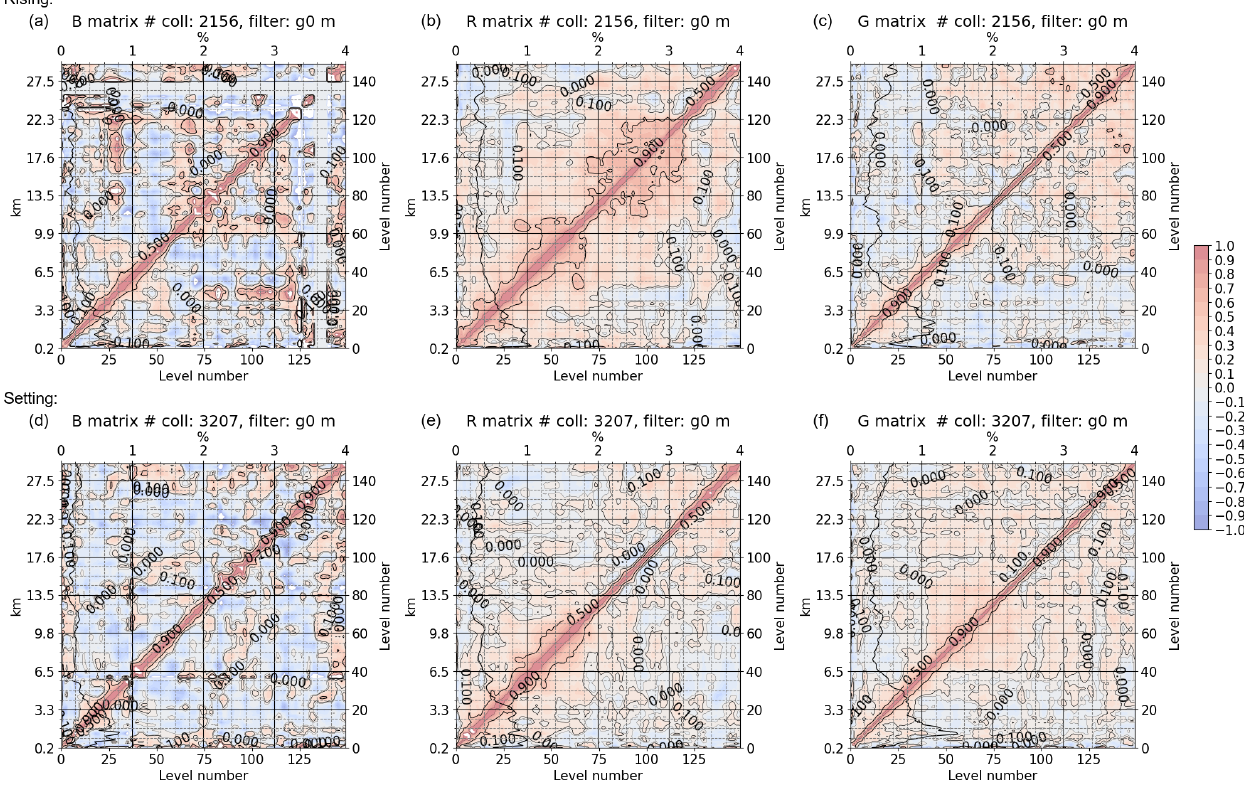
Figure 12. Same as in Fig. 11, but for high latitudes.